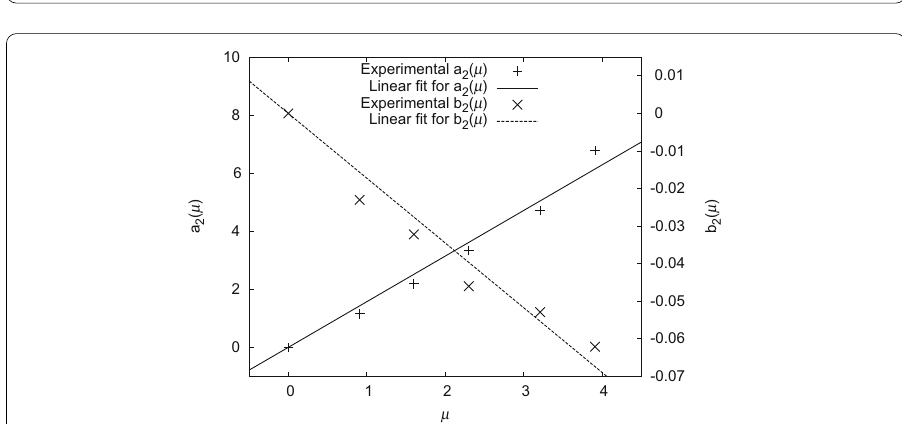
Fig. 7 Master curve obtained at the reference strain ¯ ε = 5 . 0% by shifting the responses of Fig. 6 along the log t and log σ axis (from Ref. [61])